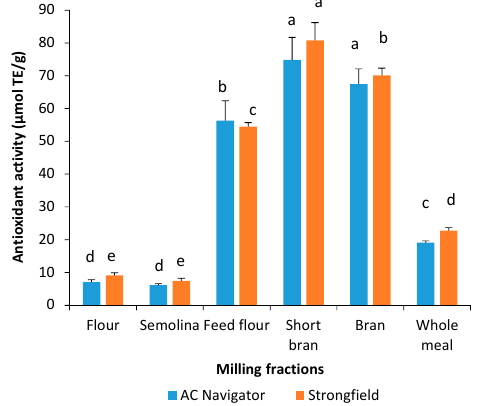
Figure 2. Free radical scavenging activity of total yellow pigment extracts using water-saturated butanol on ABTS radical. Vertical bars represent standard deviations. Different letters indicate significant differences at p < 0.05 for each genotype.